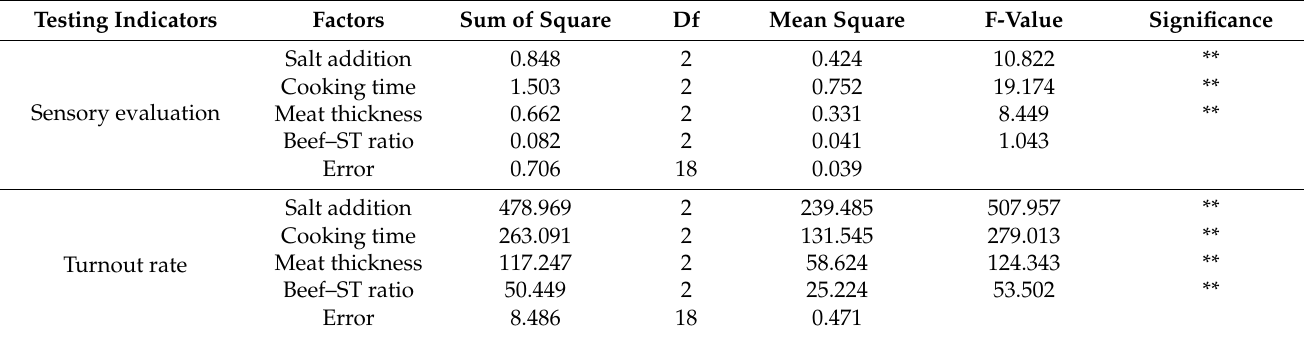
Table 4. Analysis of variance of orthogonal test